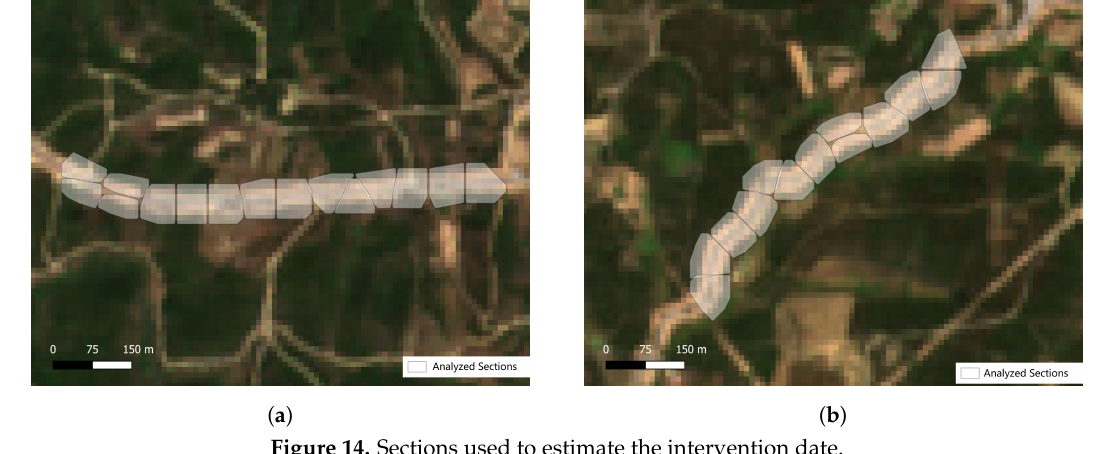
Figure 14. Sections used to estimate the intervention